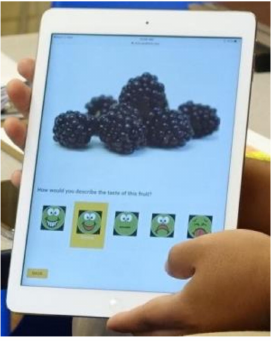
Figure 4. Modified “super yummy/super yucky” electronic recording system.